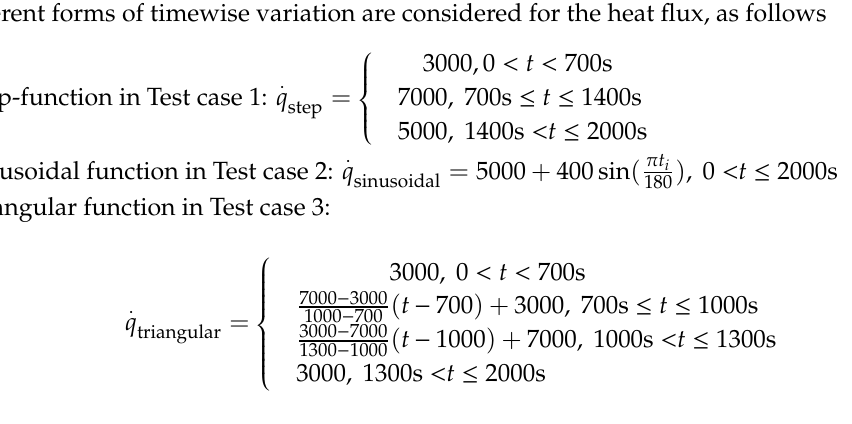
Table 1. Data used for the heat conduction problem (the body is made of stainless steel (type 304)).